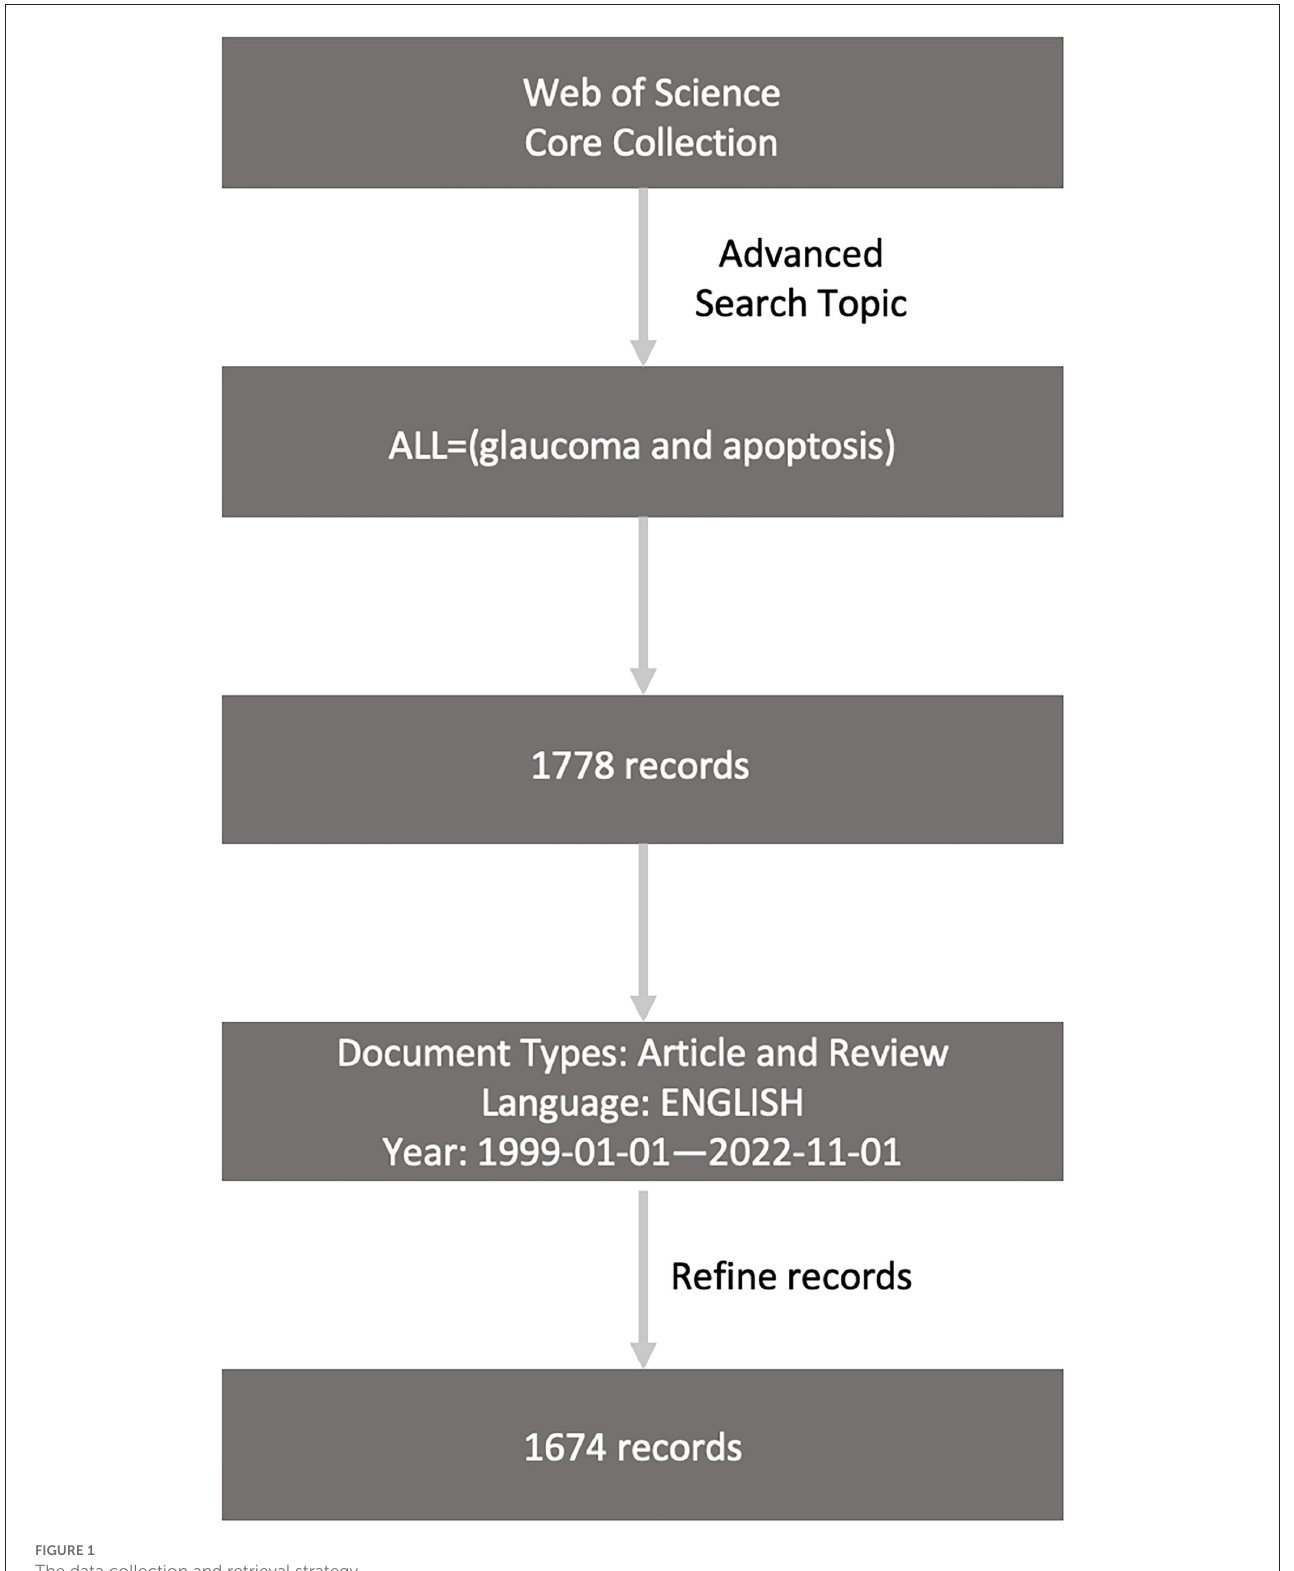
FIGURE1 The data collection and retrieval